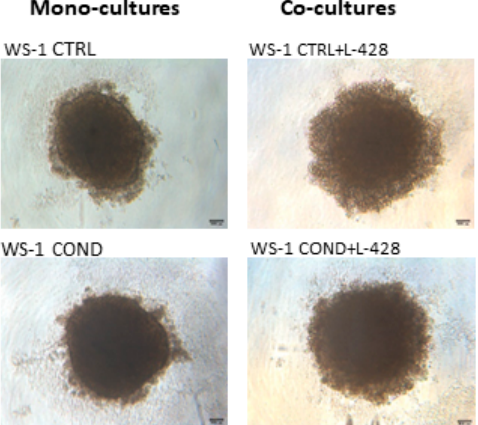
Figure 4. Optical microscopy of fibroblast spheroid mono-cultures of WS-1 CTRL and WS-1 COND and of fibroblast-lymphoma spheroid co-cultures of WS-1 CTRL + L428 and WS-1 COND + L428 (Ratio 2:1) at 24 h after cell seeding (4× magnification).